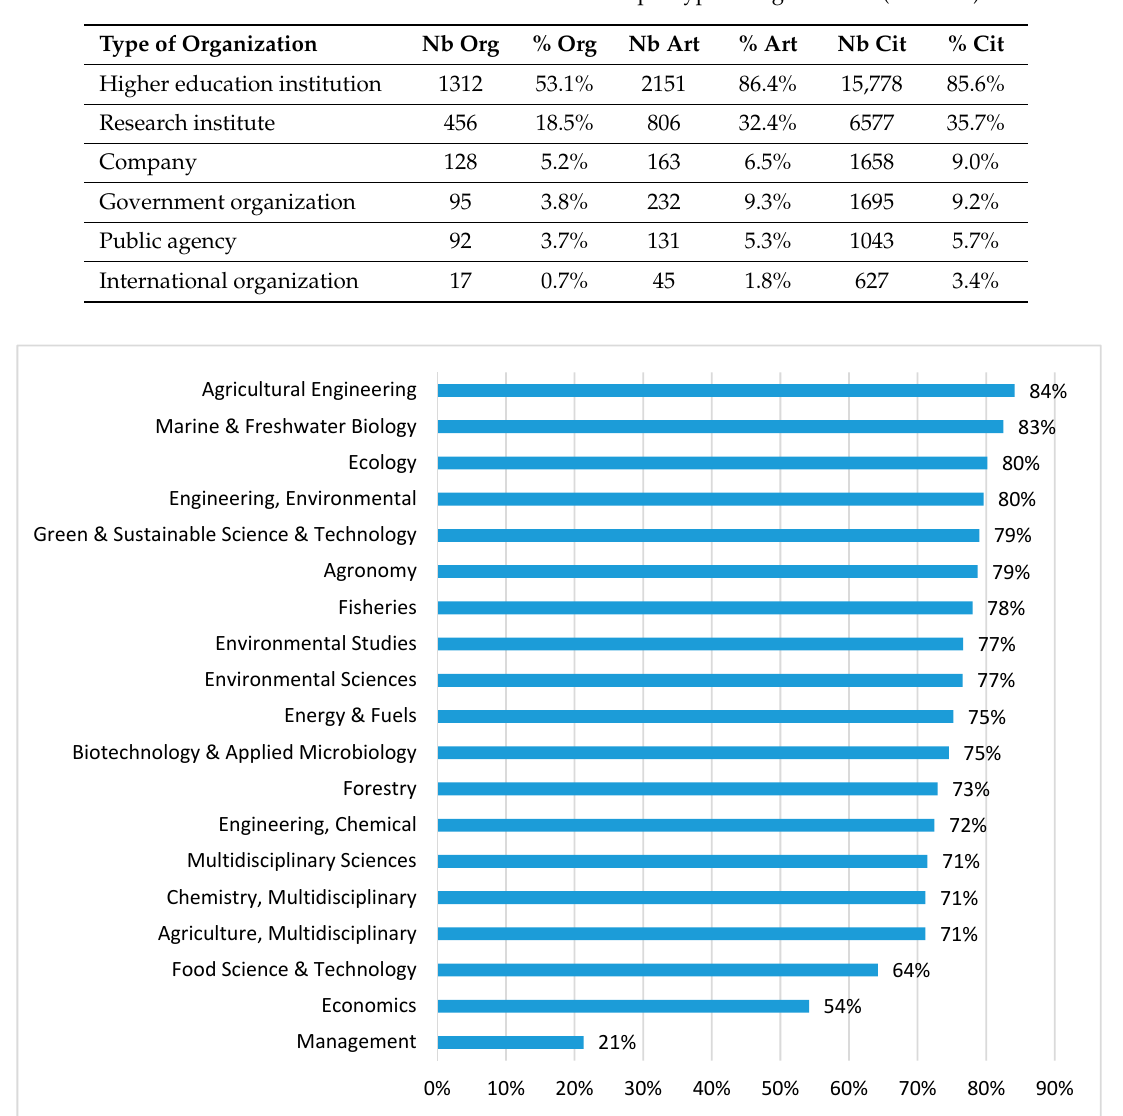
Figure 4. Funding rate per research area ( n = 1677 articles).